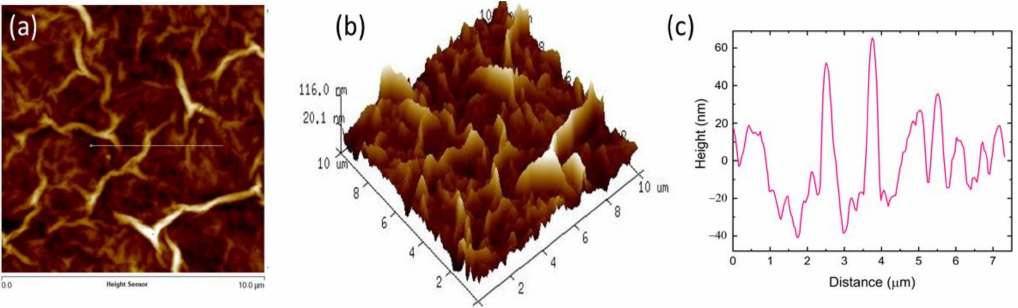
Figure 4. ( a ) 2D; ( b ) 3D topography of the atomic force microscope (AFM) image of GO film; ( c ) topographic curve of the GO film.